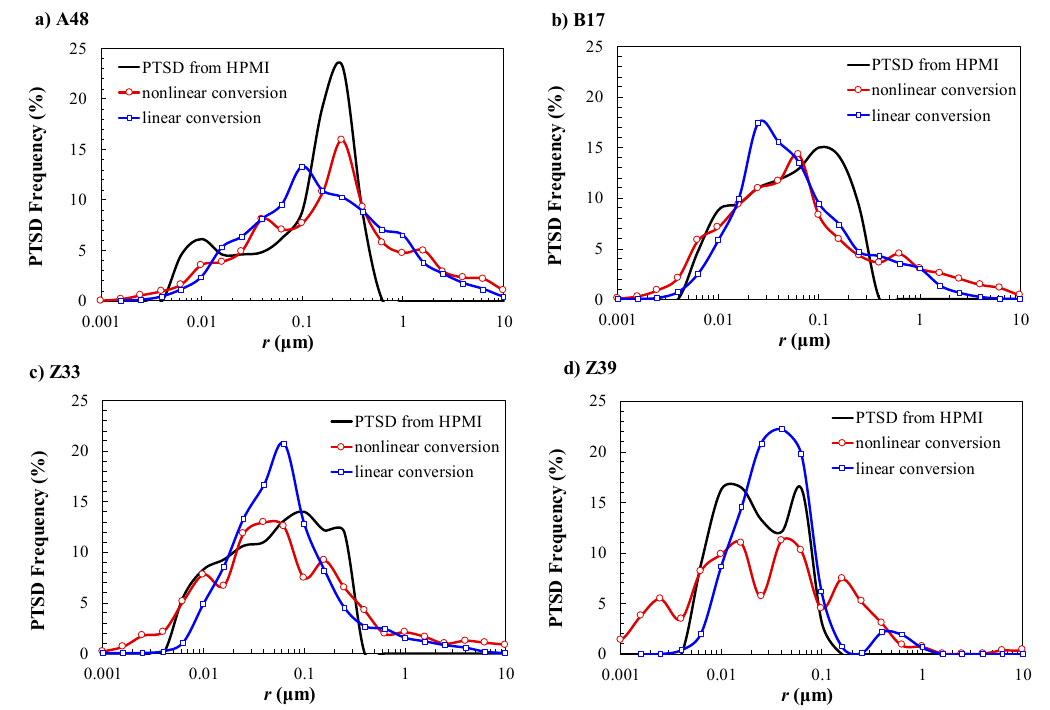
Figure 13. Comparisons of linear conversion results and nonlinear conversion results of four typical core plugs: ( a ) core plug A48; ( b ) core plug B17; ( c ) core plug Z33; ( d ) core plug Z39.